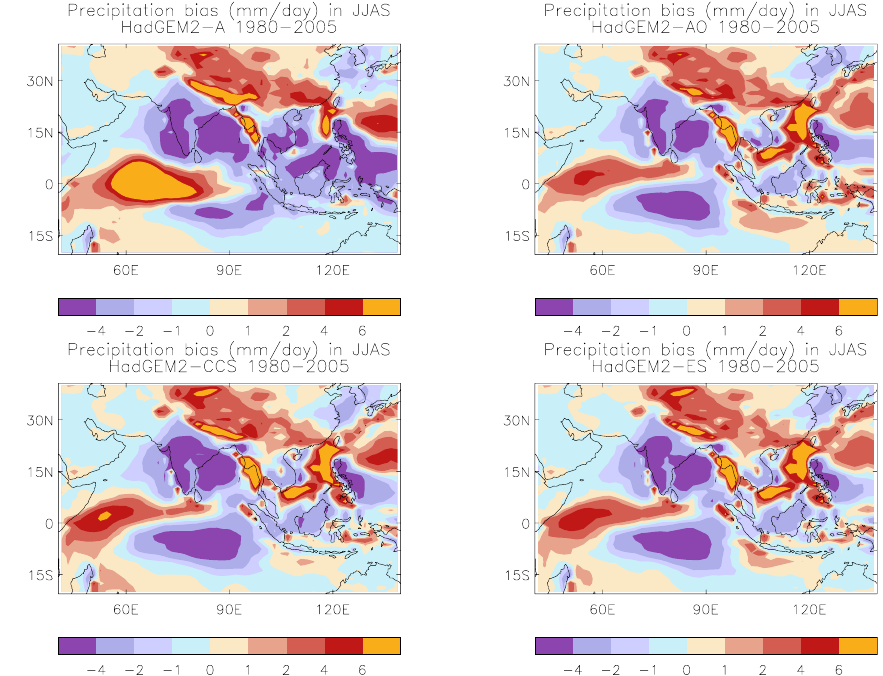
Fig. 1. Precipitation (mmday − 1 ) in June–September (JJAS) difference from observed (Climate Prediction Center – CPC; Merged Analysis of Precipitation – CMAP/O; Xie and Arkin, 1997). -A: atmosphere-only; -AO: coupled; -CCS: coupled, carbon cycle, stratosphere; -ES: coupled, carbon cycle,